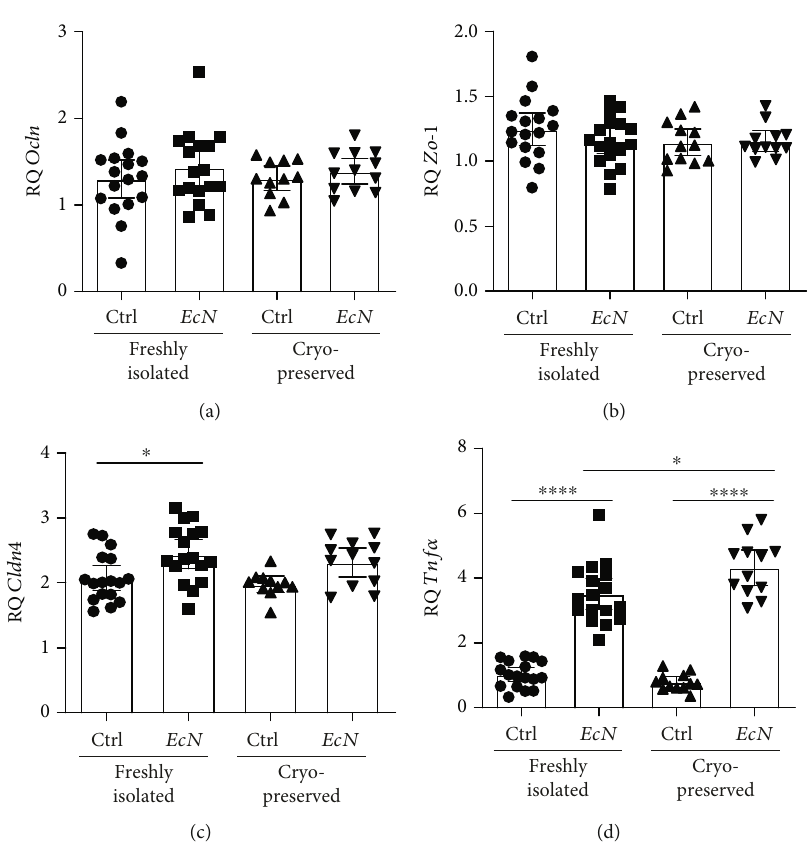
Figure 6: Cryopreservation a ff ects gene expression levels in colonoids after Ec N infection. The gene expression levels in freshly isolated colonoids ( n = 17 ) and cryopreserved and thawed organoids ( n = 12 ) of the same passage after infection with Ec N were compared. The graphs plot the pooled technical replicate means of biological replicates plus the overall mean and 95% CI. ∗ P < 0 : 05 , ∗∗ P < 0 : 01 , ∗∗∗ P < 0 : 001 , and ∗∗∗∗ P < 0 : 0001 . (a) Relative Ocln expression (ANOVA: F ð 3, 53 Þ = 0 : 4720 ; P = 0 : 7031 ). (b) Relative Zo-1 expression (ANOVA: F ð 3, 54 Þ = 1 : 010 ; P = 0 : 3953 ). (c) Relative Cldn4 expression (ANOVA: F ð 3, 53 Þ = 4 : 962 ; P = 0 : 0041 ). (d) Relative Tnf α expression (ANOVA: F ð 3, 54 Þ = 91 : 30 ; P < 0 : 0001